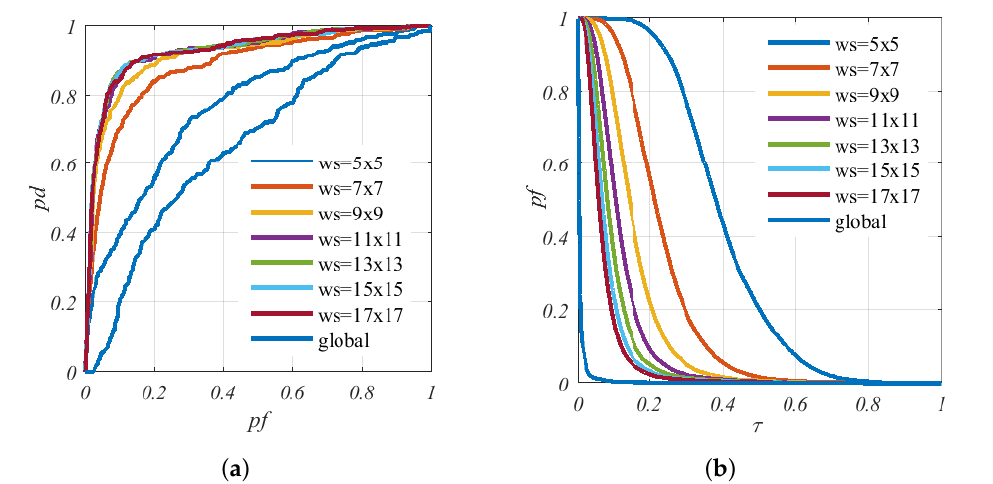
Figure 10. Receiver operating characteristic (ROC) curves analysis for AVIRIS data with different window size: ( a ) curve of ( Pd , Pf ); ( b ) curve of ( Pf , τ )